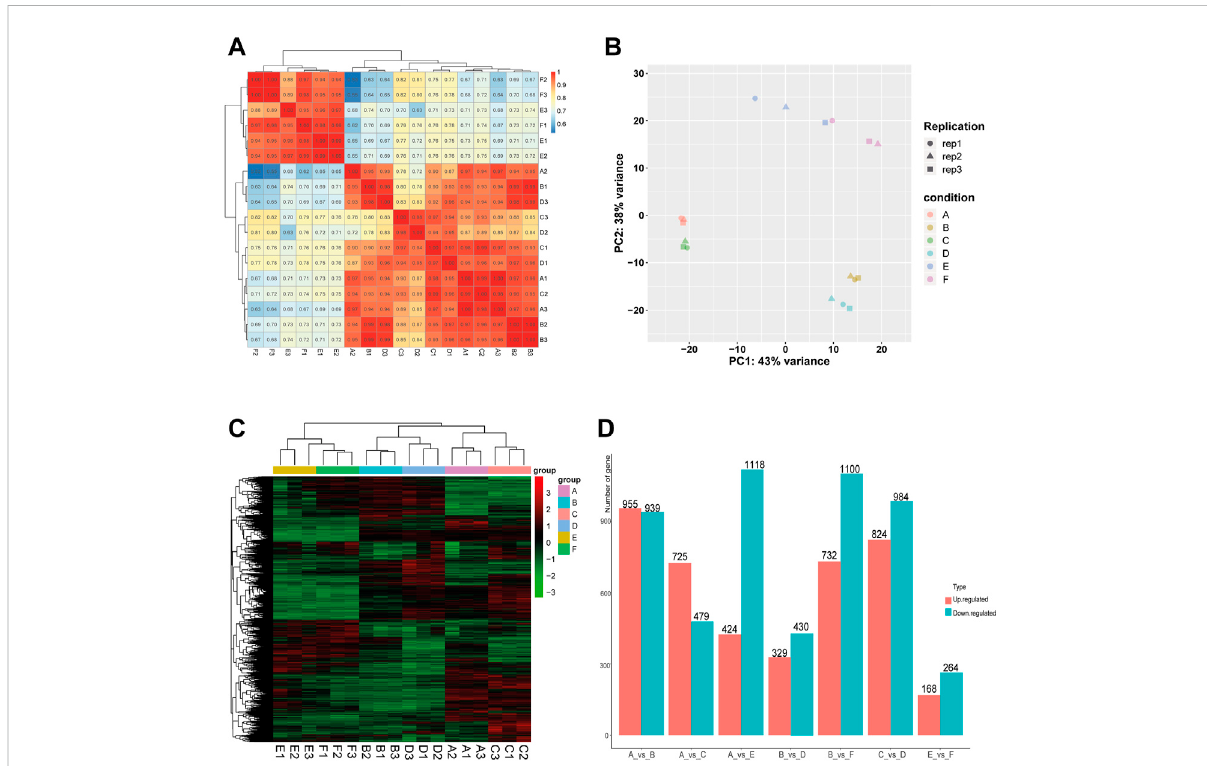
FIGURE 1 Correlation analysis of samples and screening of DEGs in the comparison between or within breeds (Mule ducks, Jinding ducks and Muscovy ducks). (A) Heatmap of correlations among groups. (B) Principal Component Analysis (PCA). Different shapes represent different replicates in the samegroup,anddifferentcolorsrepresentdifferentgroups. (C) HierarchicalclusteringanalysisofDEGs.Columnsindicatesamples,androwsdenote genes. The red represents the high gene expression and the green represents the low gene expression. (D) Statistics analysis of DEGs. The abscissa represents comparison groups, and the ordinate represents the number of DEGs. Red indicates up-regulated genes, and blue denotes down-regulatedgenes.A:femaleMuleducks,B:maleMuleducks,C:femaleJindingducks,D:maleJindingducks,E:femaleMuscovyducks,F:male Muscovy